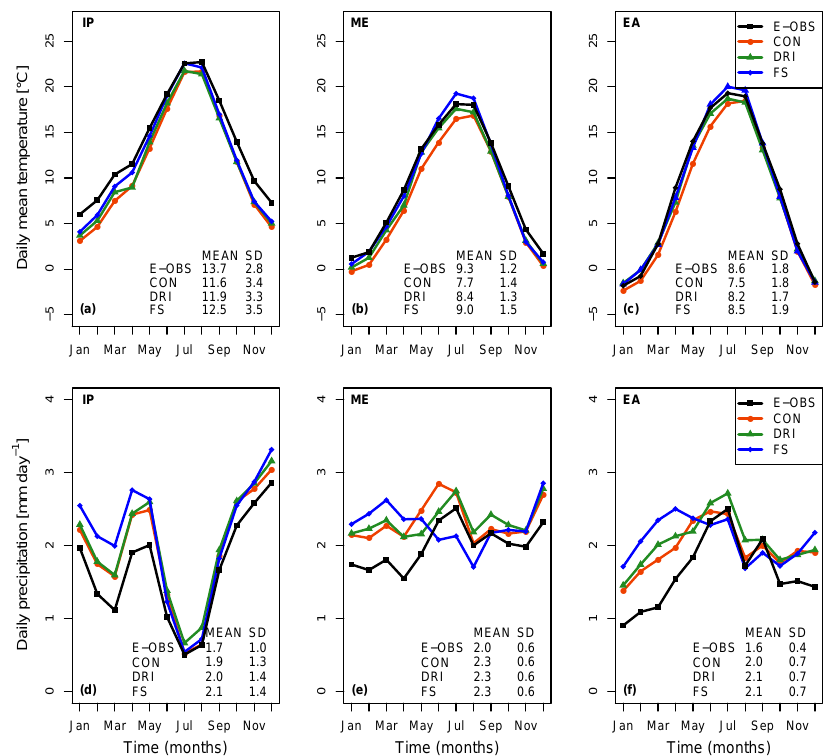
Figure 5. Mean annual cycle of the daily 2m temperature ( ◦ C) with E-OBS, CON, DRI and FS for (a) the Iberian Peninsula, (b) mid-Europe, and (c) eastern Europe and daily accumulated precipitation (mmday − 1 ) for (d) the Iberian Peninsula, (e) mid-Europe and (f) eastern Europe, averaged over the 10-year period from 1991 to 2000. Both the mean and standard deviation (SD) are displayed as